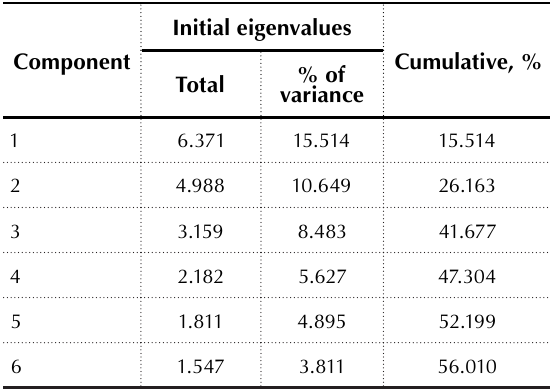
industry value chain in Zimbabwe